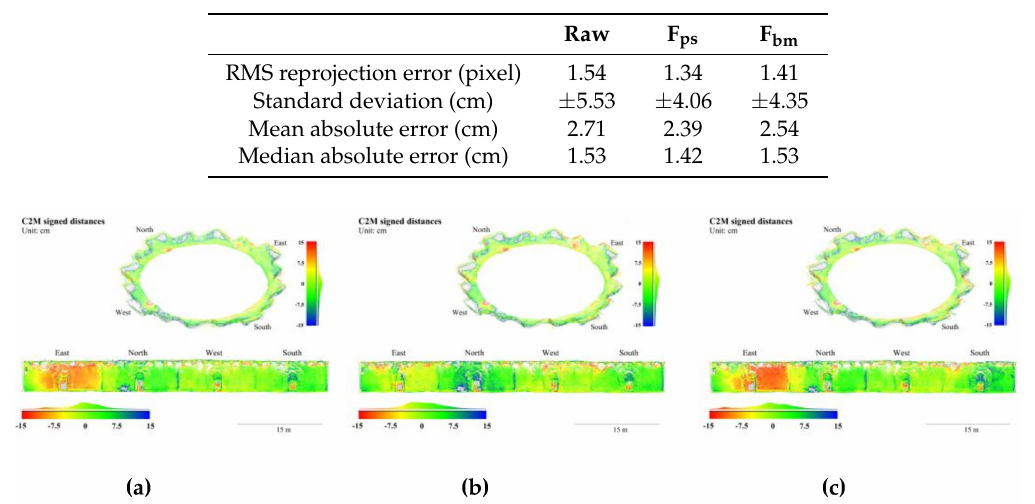
Table 5. Statistic results of the accuracy assessment of the Pavilion: raw frames and blur-filtered frames.